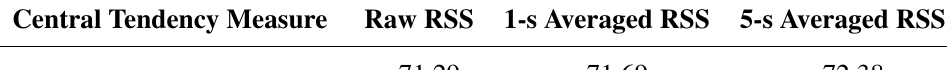
Table 1. Mean and median of static RSS measurements (these values correspond to the mean and median shown in Figure